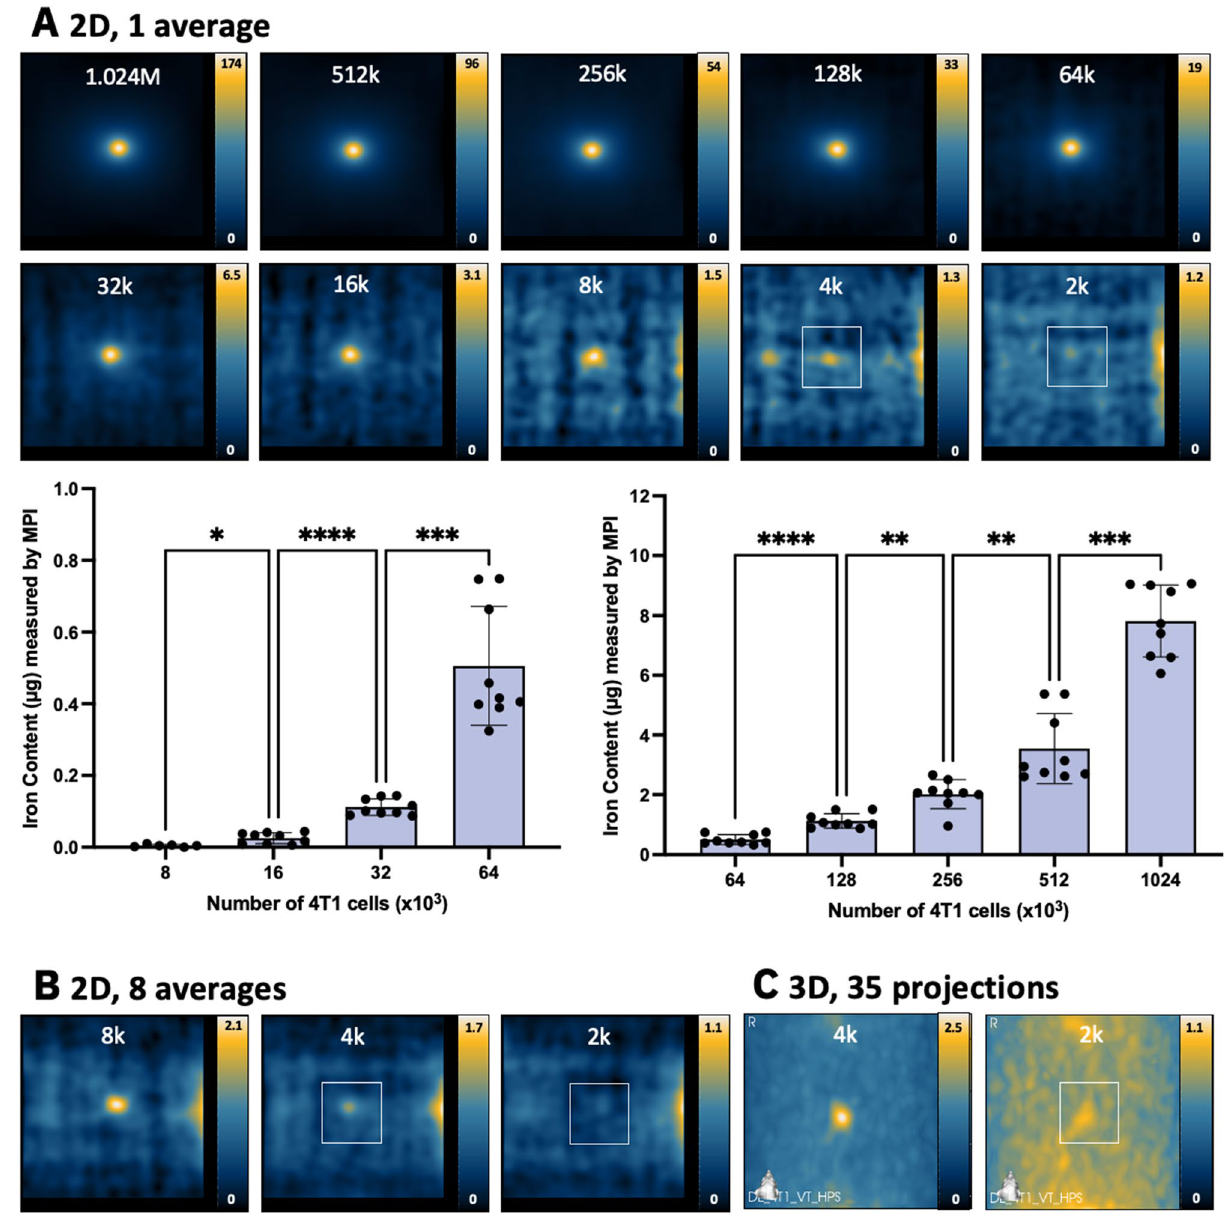
Figure 2. MPI detection of ferucarbotran-labeled 4T1 cells. ( A ) 2D MPI of individual 4T1 cell pellets containing the indicated cell numbers (M = 10 6 , k = 10 3 ). As few as 8000 cells (0.074 μg ferucarbotran) could be detected with SNR > 5 in 1.5 min. 2D MPI signal (and the associated iron content) significantly increases with the number of 4T1 cells (* P < .05, ** P < .01, *** P < .001, **** P < .0001). ( B ) With 8 signal averages, the same result was found. ( C ) In 3D, the detection of 4000 cells (0.037 μg ferucarbotran) with SNR > 5 was possible in 23 min. Images with SNR < 5 have white boxes to indicate the placement of the cell In 19 F images (with imaging time = 1.5 min/pellet), the range of 256–1024 × 10 3 PFPE-labeled MSC were detected (Fig. 4A) and 19 F signal was strongly correlated with cell number (R 2 = 0.9983) (Fig. 5C). The average number of cells detected per voxel from these scans was 1.30 ± 0.51 × 10 5 cells/mm 3 . The lowest cell number detected from these 19 F scans was 256 × 10 3 MSC (9.01 × 10 16 19 F atoms, 30.21 mM), which was detected in 4 of 9 replicates with SNR > 5. 19 F signal measured from 1.024 × 10 6 MSC was significantly higher than signal measured from 512 × 10 3 cells ( P < 0.01), which was higher than signal measured from 256 × 10 3 cells ( P < 0.05) (Fig. 4C). With longer imaging times (4.5 min/pellet), 19 F sensitivity was improved (Fig. 4B) and the SD noise was sig- nificantly reduced compared to 1.5 min/pellet scans ( P < 0.0001). The average number of cells detected per voxel from these scans was 8.55 ± 2.97 × 10 4 cells/mm 3 . As few as 128 × 10 3 MSC (4.51 × 10 16 19 F atoms, 19.01 mM) were detected with SNR > 5 in 3 of 9 replicates. Additionally, 19 F signal with SNR > 5 was detected in 7 of 9 replicates of 256 × 10 3 MSC, which corresponds to 9.01 × 10 16 19 F atoms (28.01 mM). Significant differences in 19 F signal